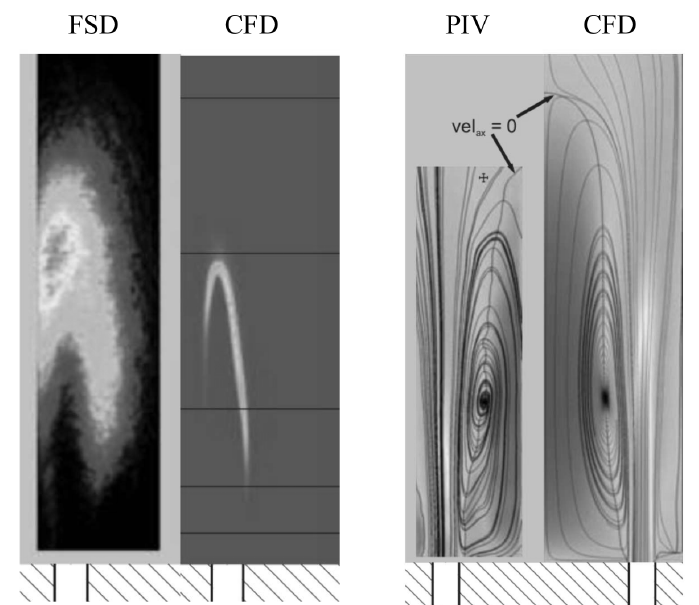
Figure 8. ( Left ): Comparison of OH* chemiluminescence flame surface density (FSD) [42] with specific reaction heat. ( Right ): Comparison of experimental PIV axial velocities [42] and averaged CFD flow field. Light colors denote high values and vice